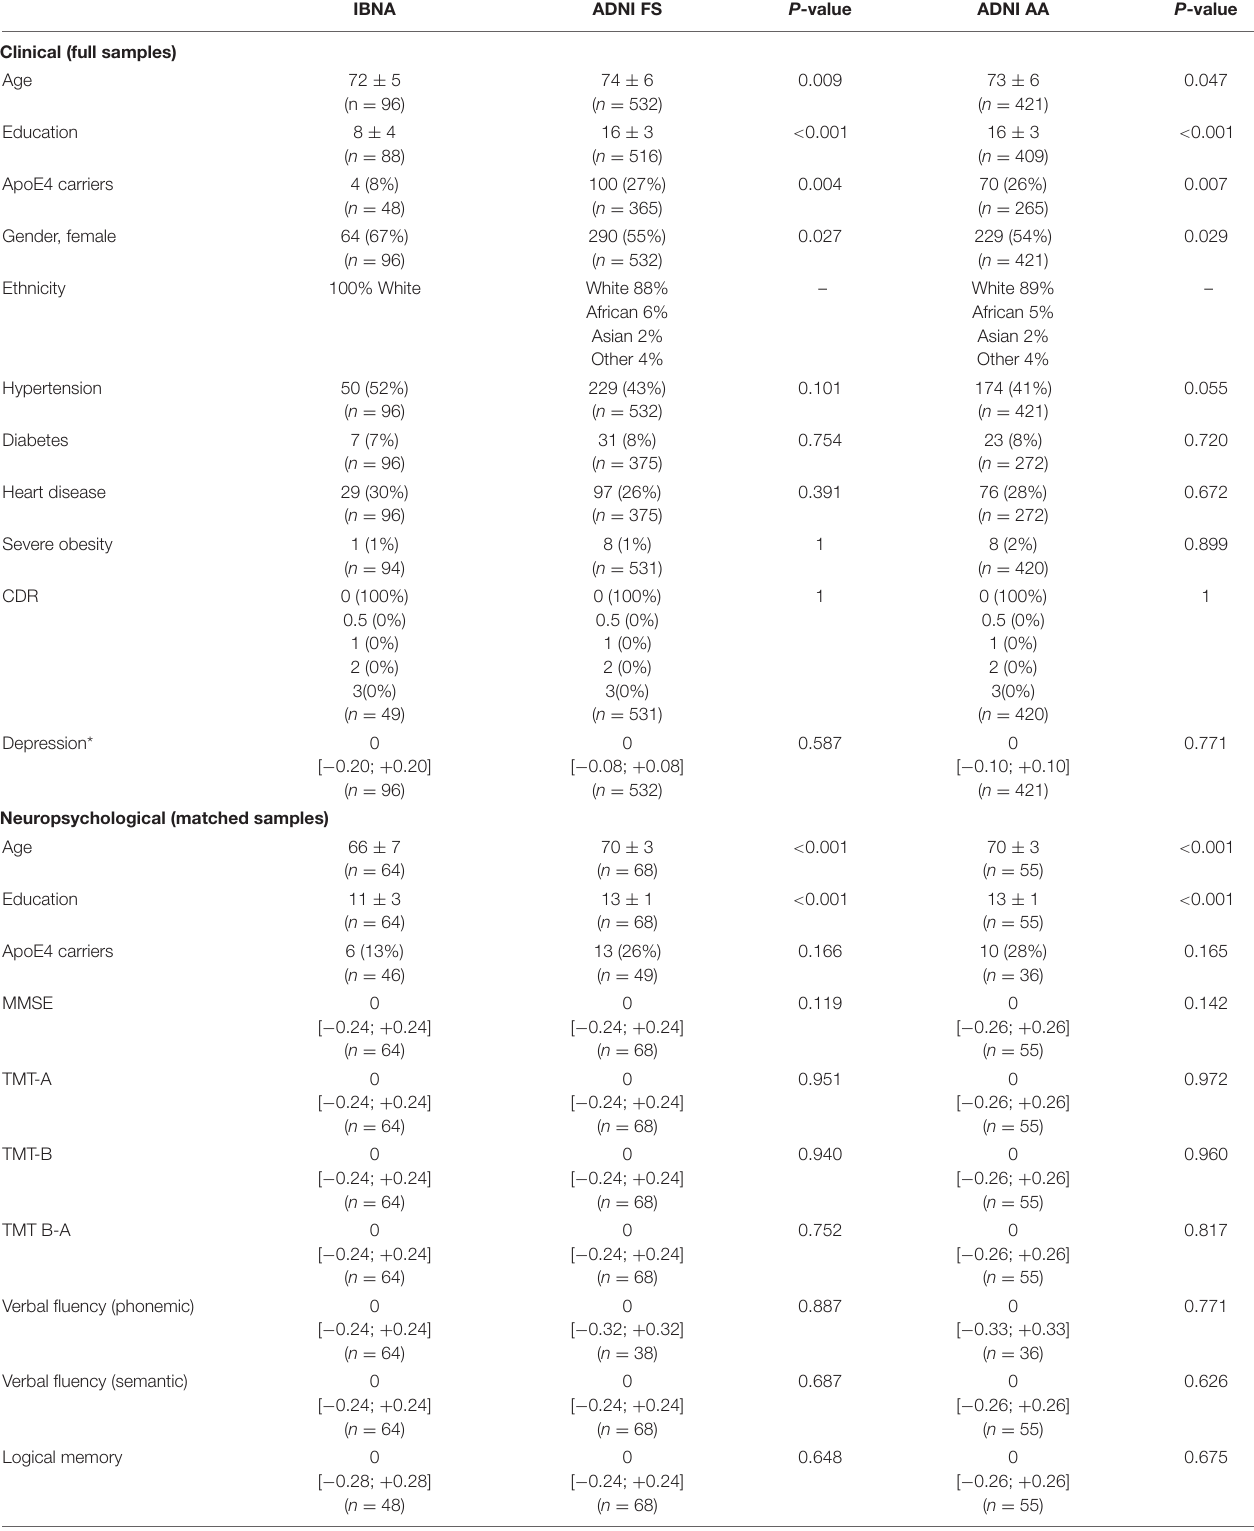
TABLE 1 | Clinical, neuropsychological, morphological features comparisons between IBNA and ADNI data sets. IBNA ADNI FS P -value ADNI AA P